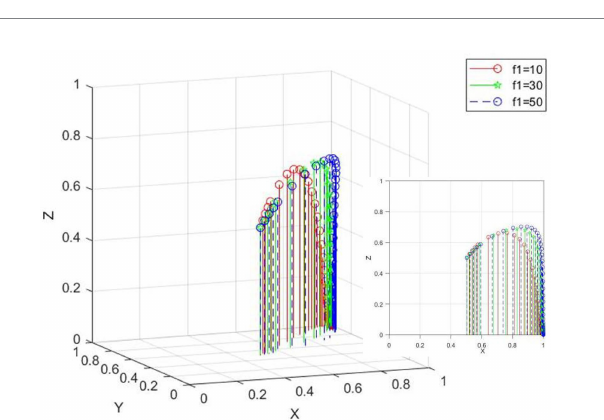
FIGURE 4 Impact diagram of rent-seeking costs (Scenario 2).